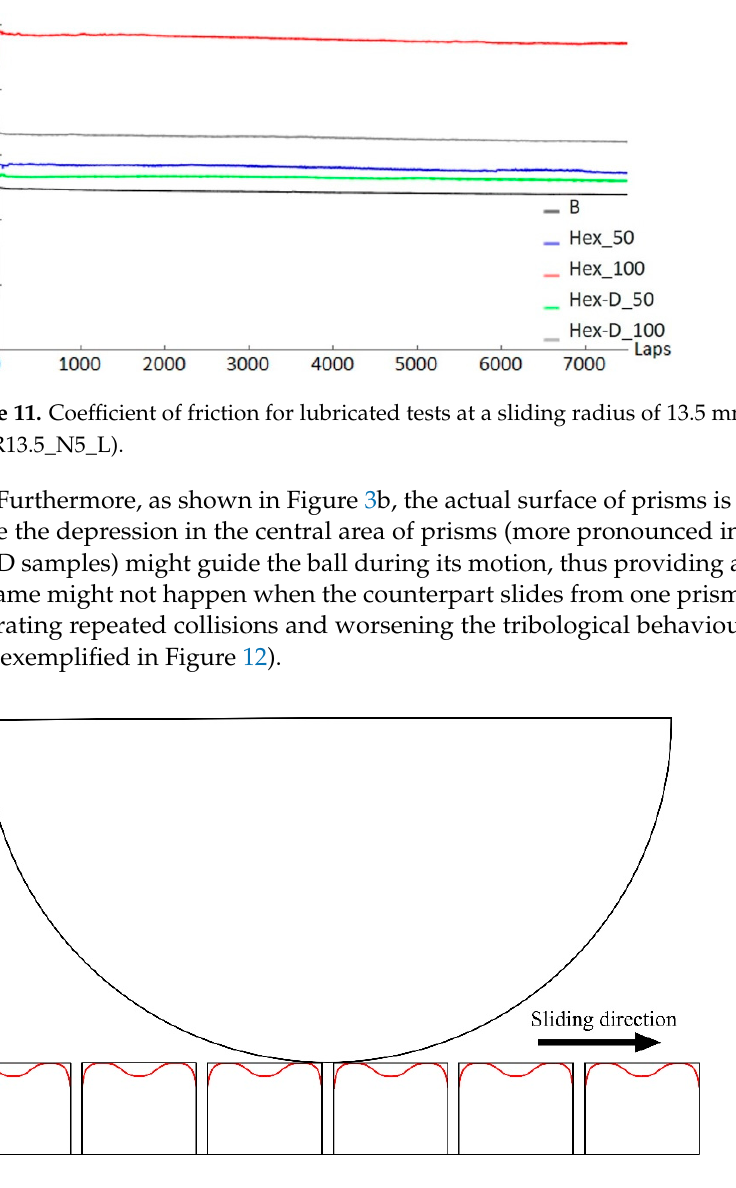
Figure 12. Sliding pair, geometrical effect related to the actual shape of the 3D-printed features.